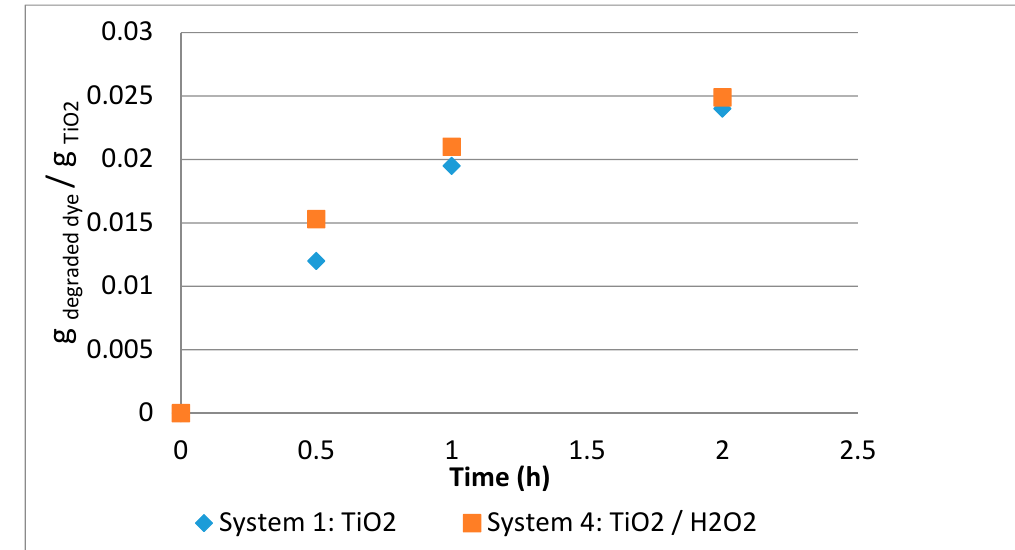
Figure 17. Comparison of the dye degradation curves for Systems 1 and 4. Environments 2019 , 6 , x FOR PEER REVIEW